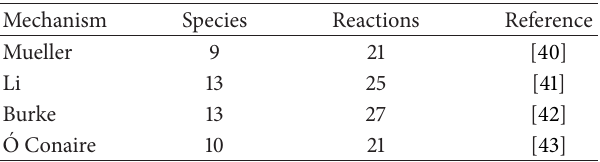
Table 2: Number of species and reactions in the considered